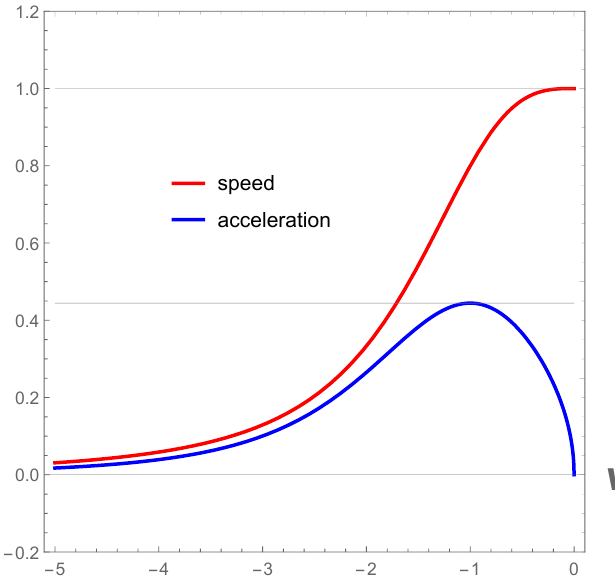
Figure 3. Magnitude of the velocity and proper acceleration as a function of light-cone coordinate advanced time v = t + x for the mirror trajectory, Equation (5). It is readily seen that at v = 0, the velocity, V , approaches the speed of light, | V | → c = 1, and the proper acceleration vanishes, α → 0. The maximum acceleration occurs at advanced time v = − M and is | α max | = 4/ ( 9 M ) = 0.444 M − 1 . Here, M =